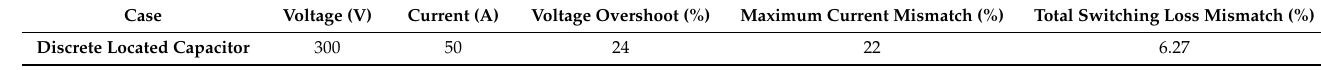
Table 8. Proposed half-bridge circuit